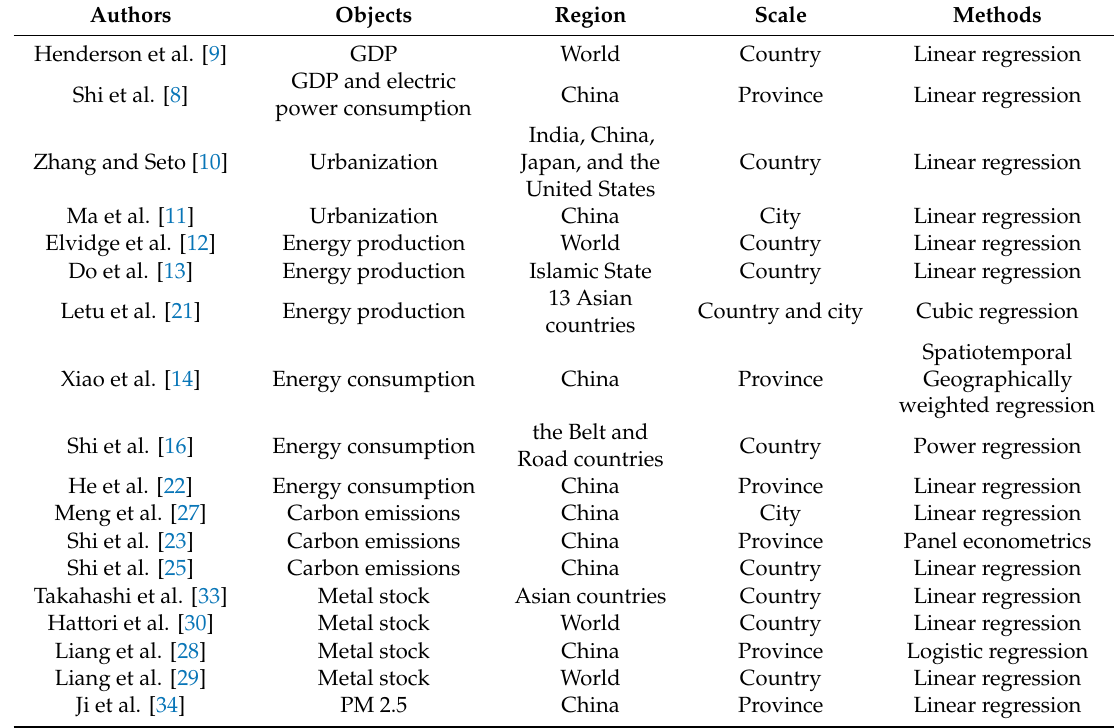
Table 1. Summary of nighttime light data